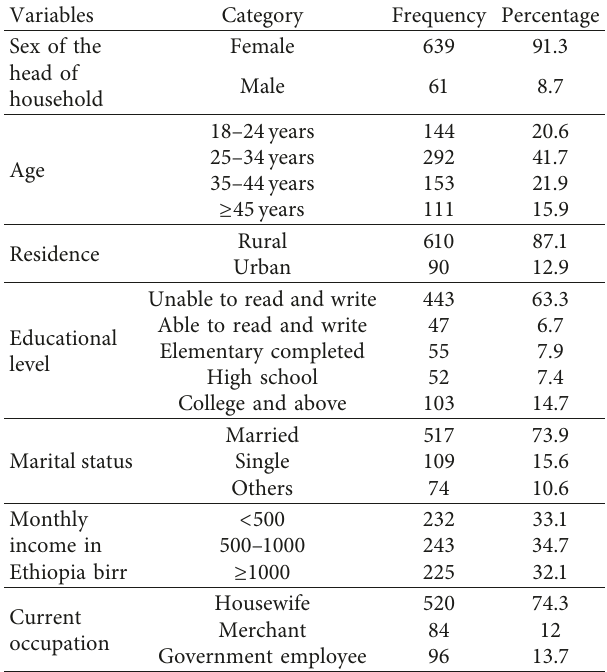
Table 1: Sociodemographic characteristics of the head of house- holds in the Mecha District, Western Amhara, Ethiopia, 2018 ( N � 700).